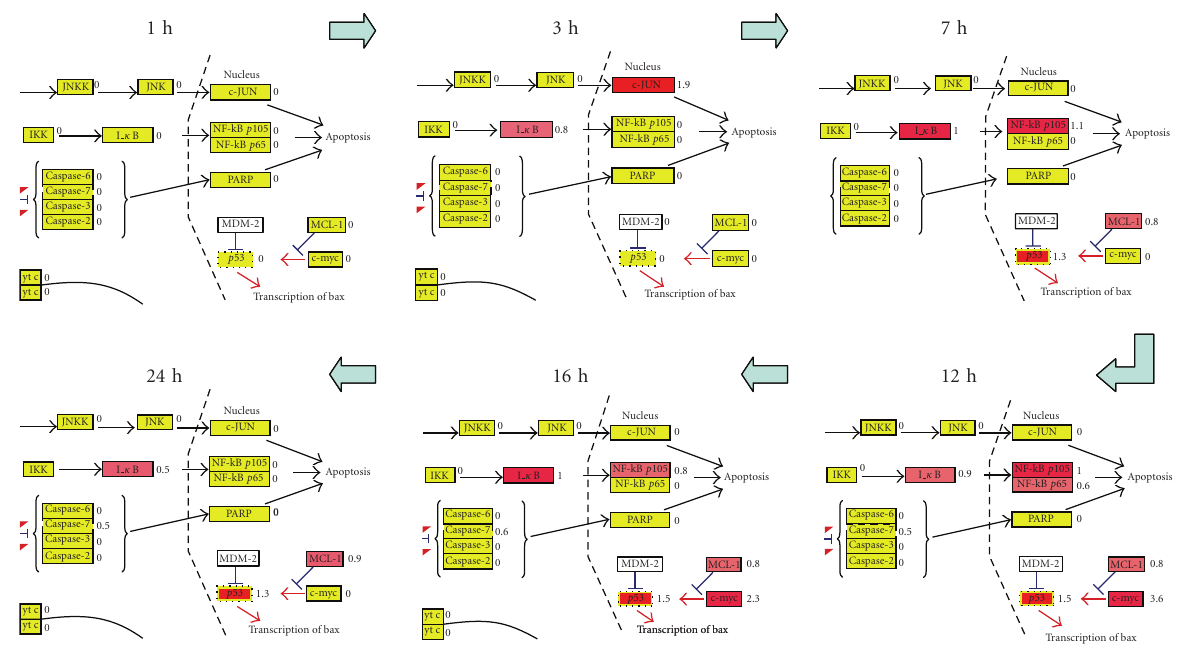
Figure 2: Apoptosis map. Expression data of Rhok − / − /Sag − / − mice was overlaid onto a hypothetical apoptosis map using the GenMAPP (http://www.genmapp.org) program. Each rectangle represents a gene in the pathway. The number on the right of the rectangle corresponds to the log 2 ratio. Genes highlighted in yellow are unchanged. Pink and red denote upregulated genes while dark and light green correspond to downregulated genes. Rhok − / − /Sag − / − mice were exposed to 1 hour of low light (450lux) and adapted for the indicated time period of